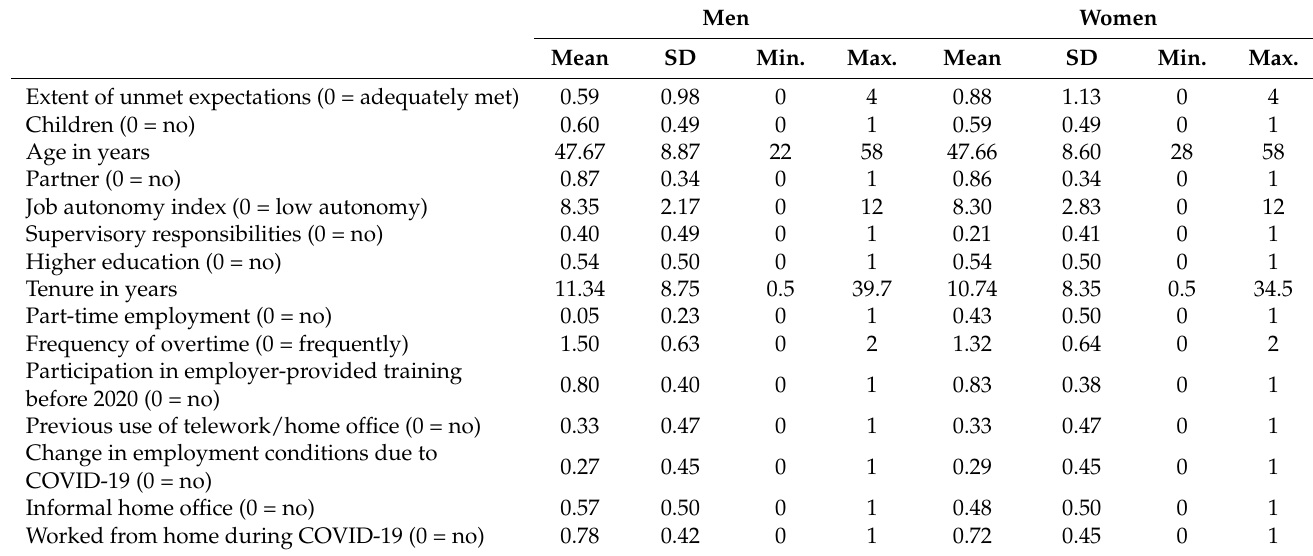
Table 1. Individual-level descriptive statistics ( N = 557).